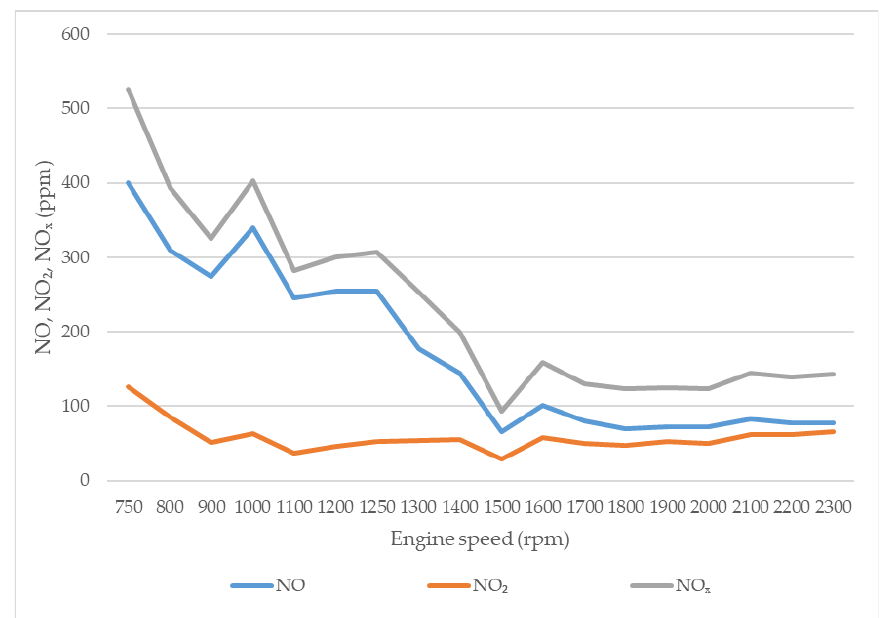
Figure 4. Changes in NO, NO 2 , and NO x concentrations in relation to the engine speed.